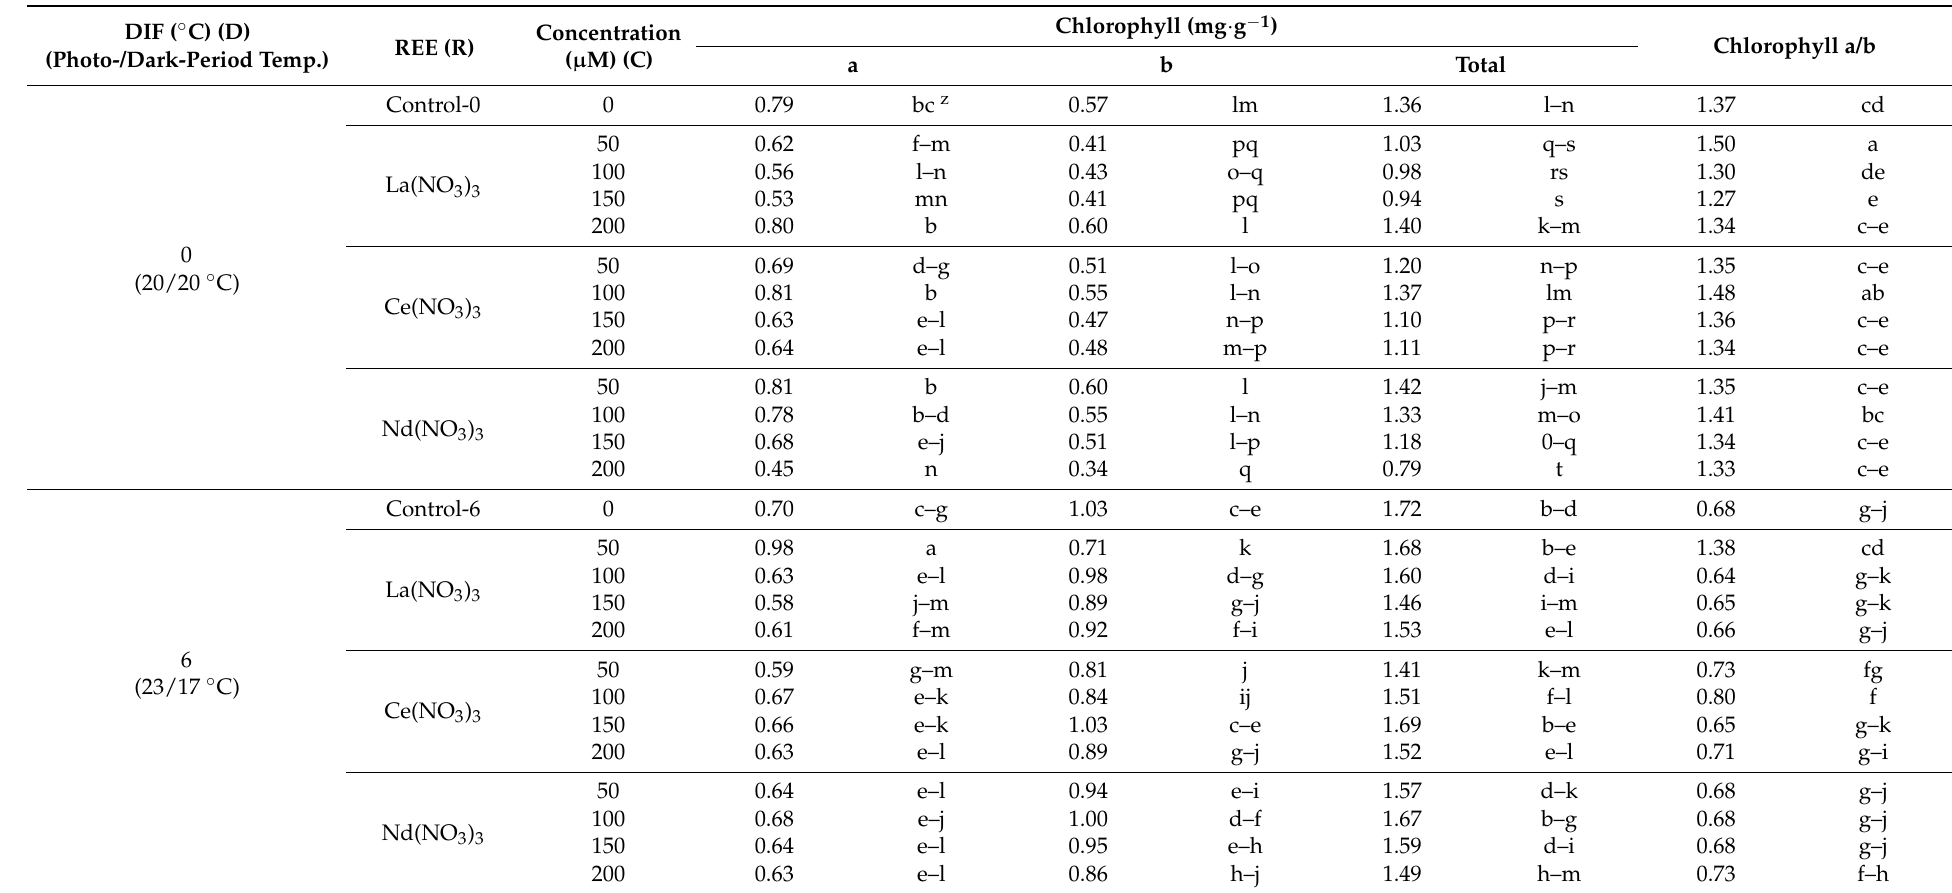
Table 2. Effect of the DIF and REE supplementation on leaf chlorophyll content of D. aphyllum